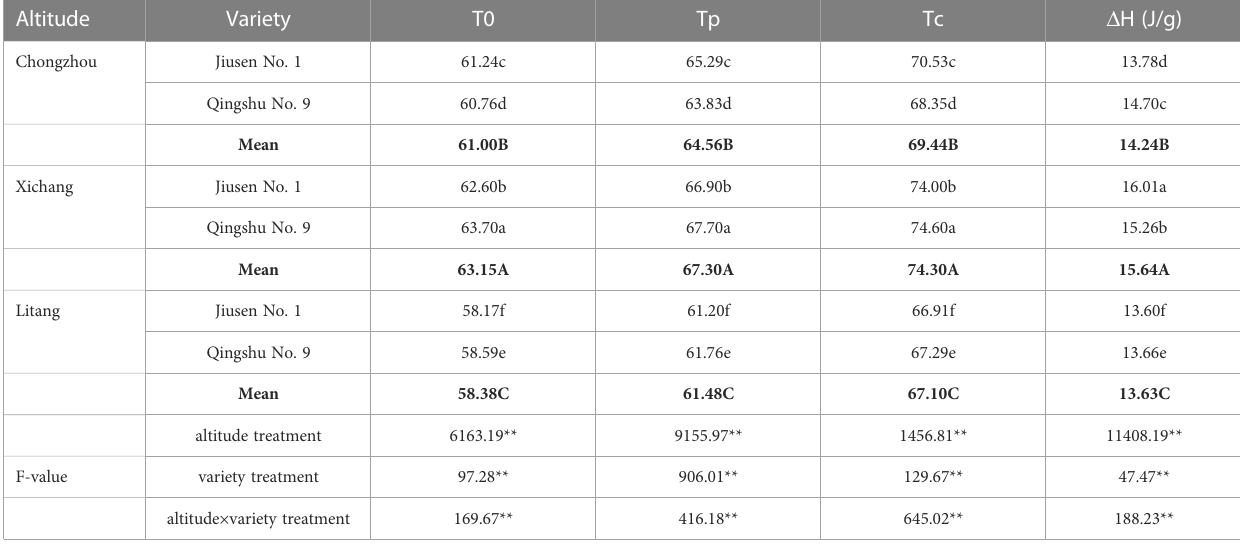
TABLE 6 Thermodynamic properties of potato starch at different altitudes. Altitude